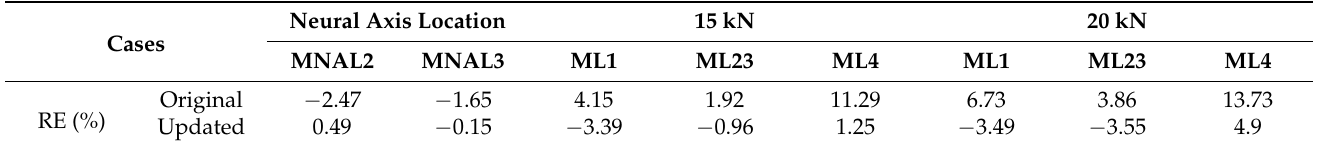
Table 9. Defined error indices for the updated